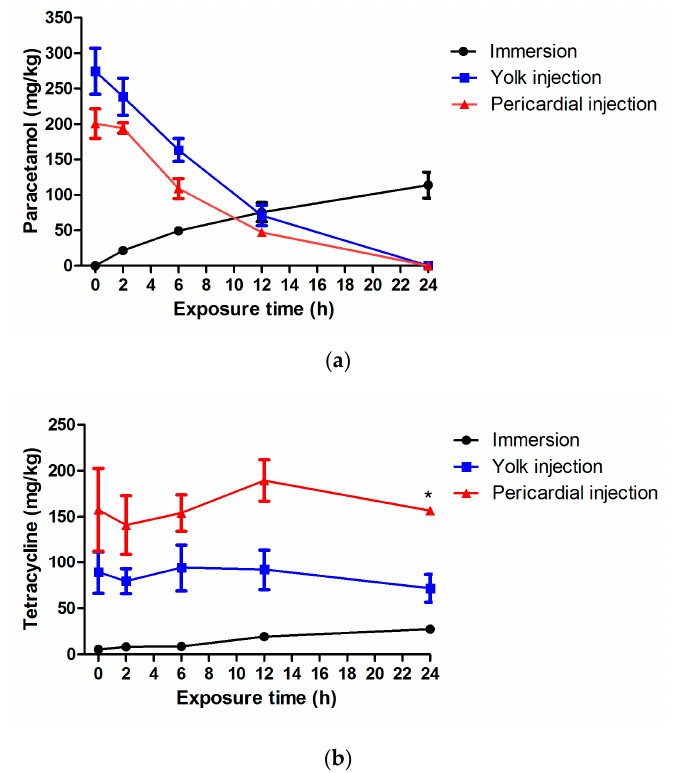
Figure 7. Pharmacokinetics after immersion, yolk and pericardial injection of paracetamol ( a ) and tetracycline ( b ). The compounds in larval extracts were quantified by ultra-high performance liquid chromatography with ultraviolet detection (UHPLC-UV) as a function of time (0–24 h post treatment). n = 3, *: consists of two measurements. Means ± SD are shown.